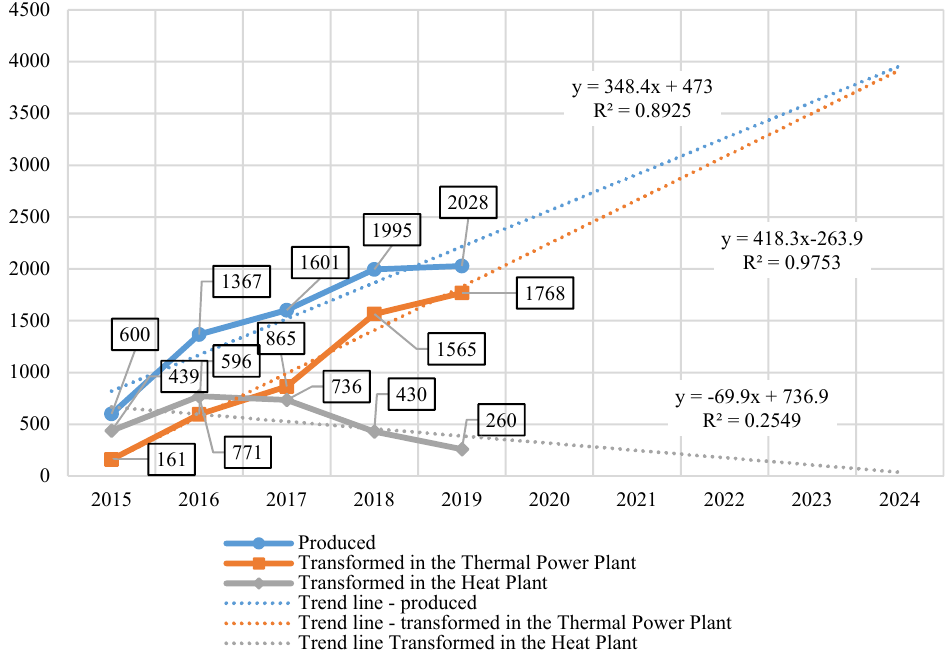
Figure 3. Trend model of biogas production and conversion. Source: own calculation.